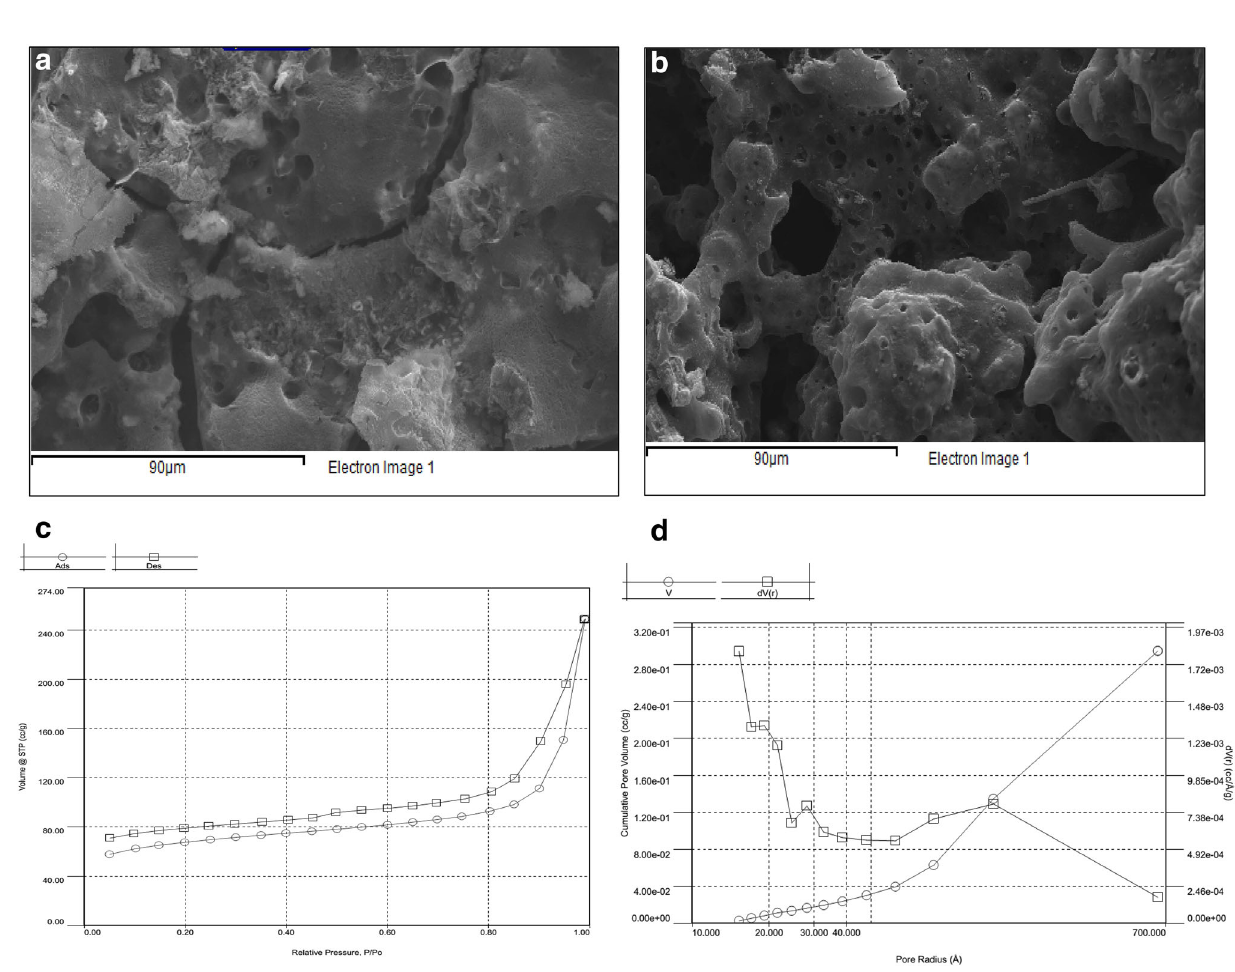
Fig. 2 Scanning electron micrograph of a CCSFP and b fluoride-loaded CCSFP. c Nitrogen adsorption–desorption isotherm curve of CCSFP. d Pore size distribution of